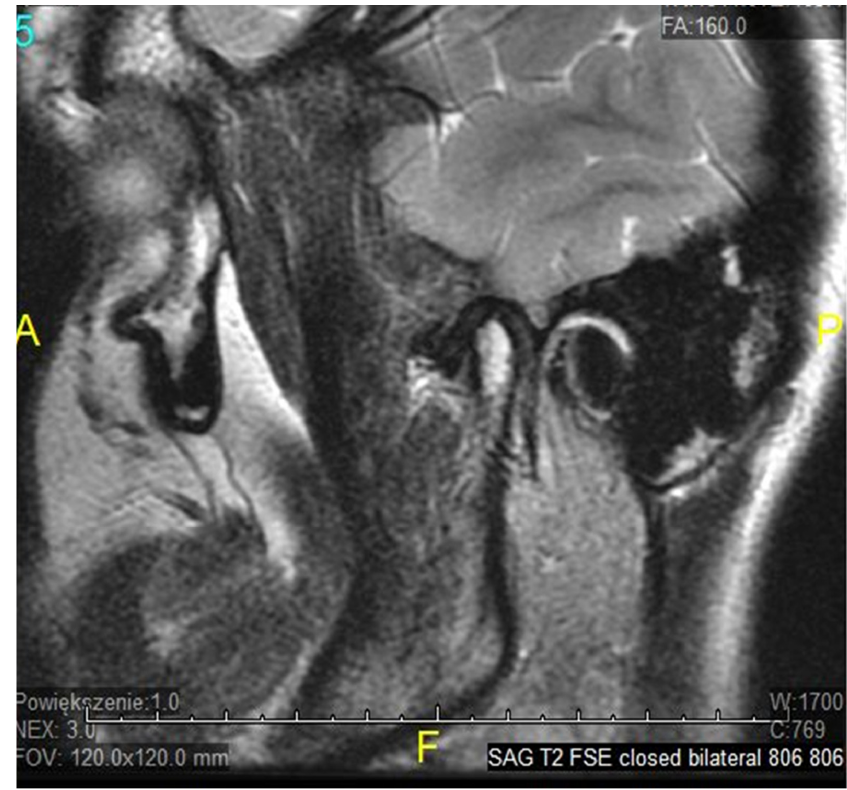
Figure 1. ADDwoR sagittal view—closed.